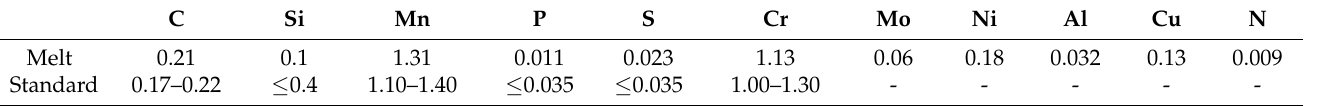
Table 1. Chemical composition of the melt used (all results given in mass percent